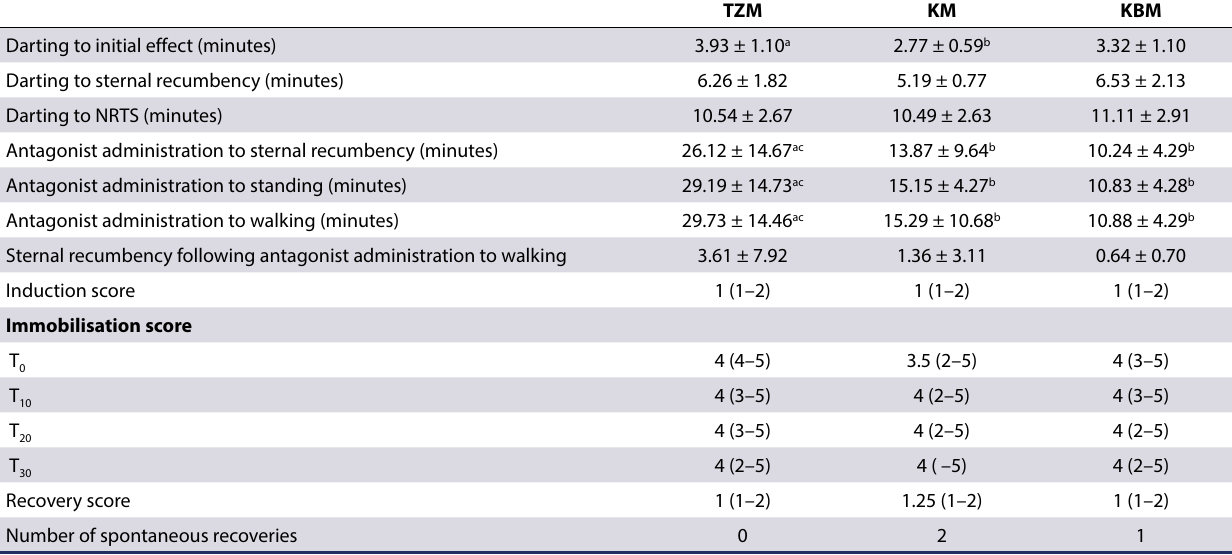
Supplementary Table I: Times and quality scores of inductions, immobilisation, and recovery recorded in free-ranging African lions ( Panthera leo ) immobilised with tiletamine-zolazepam-medetomidine (TZM), ketamine-medetomidine (KM) and ketamine-butorphanol-medetomidine (KBM). Time periods (minutes) are presented as mean ± SD. Scores are presented as median (range), ( n = 12 per drug